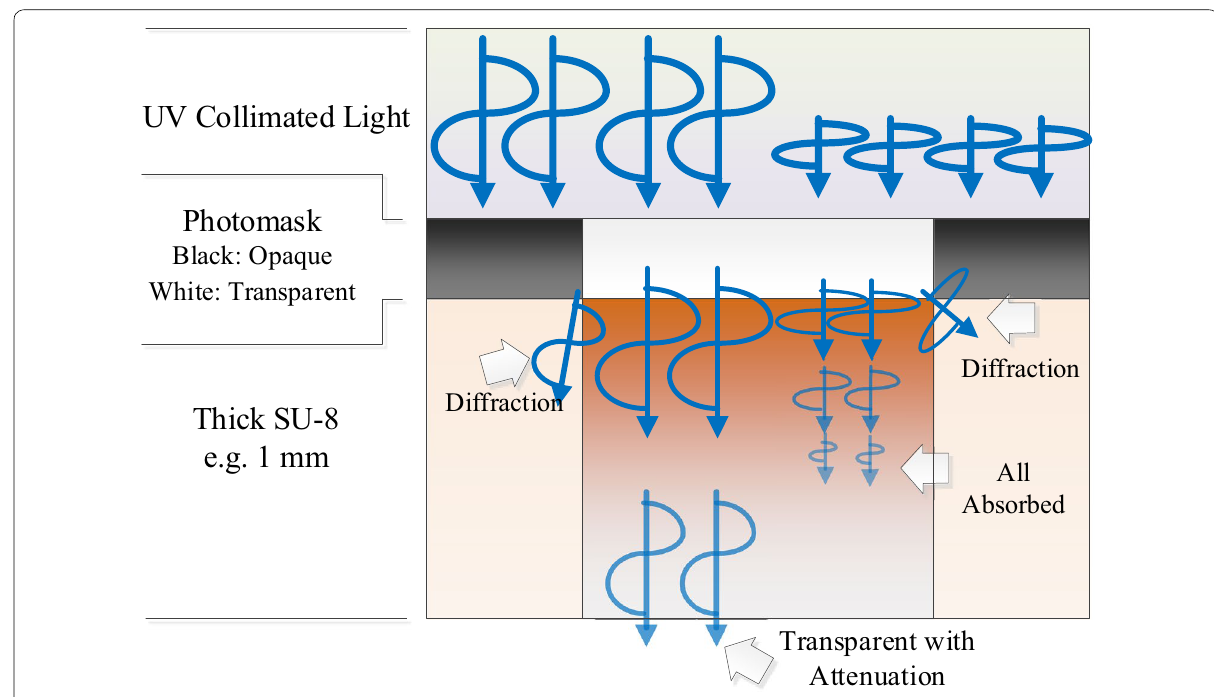
Fig. 1 Description of a short- and long-wavelength UV light propagation during the backside UV exposure for SU-8 pillar